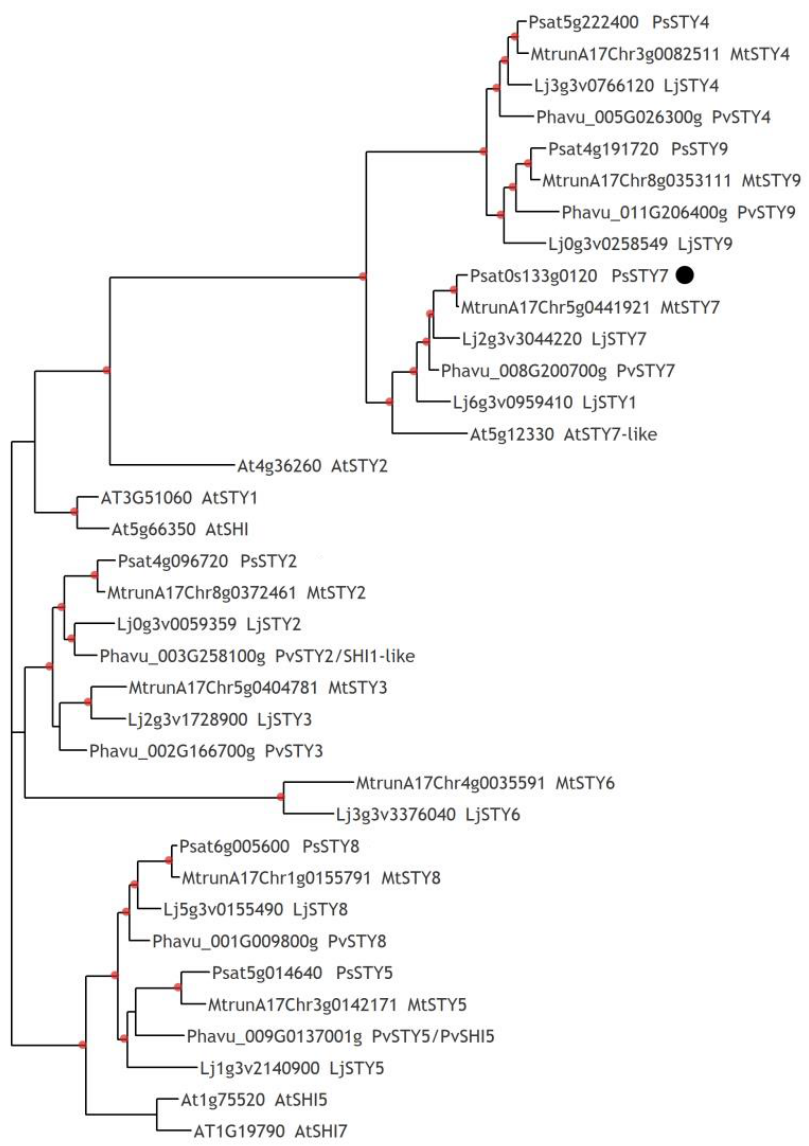
Figure 7. Phylogenetic tree constructed by the maximum likelihood method based on the amino acid sequences of the STY family genes in model legume plants L. japonicus, P. vulgaris, A. thaliana, and M. truncatula , as well as in P. sativum . Red dots indicate over 0.7 support based on 1000 iterations of the bootstrap method. The black dot indicates the gene of interest.